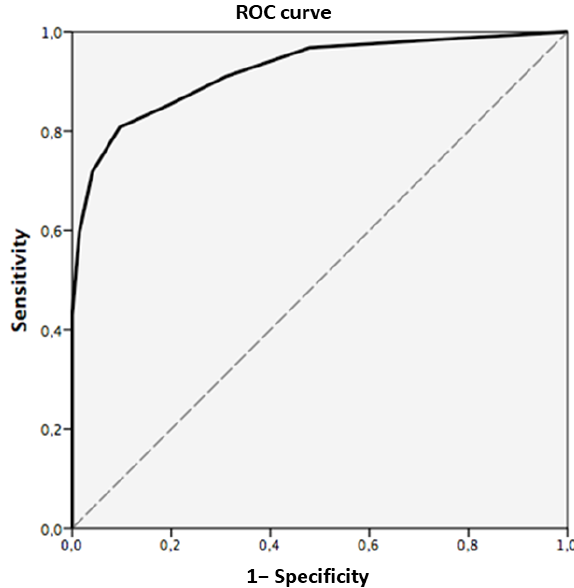
Figure 1. Receiver Operating Characteristic curve for Frontal Assessment Battery score in healthy controls and dementia